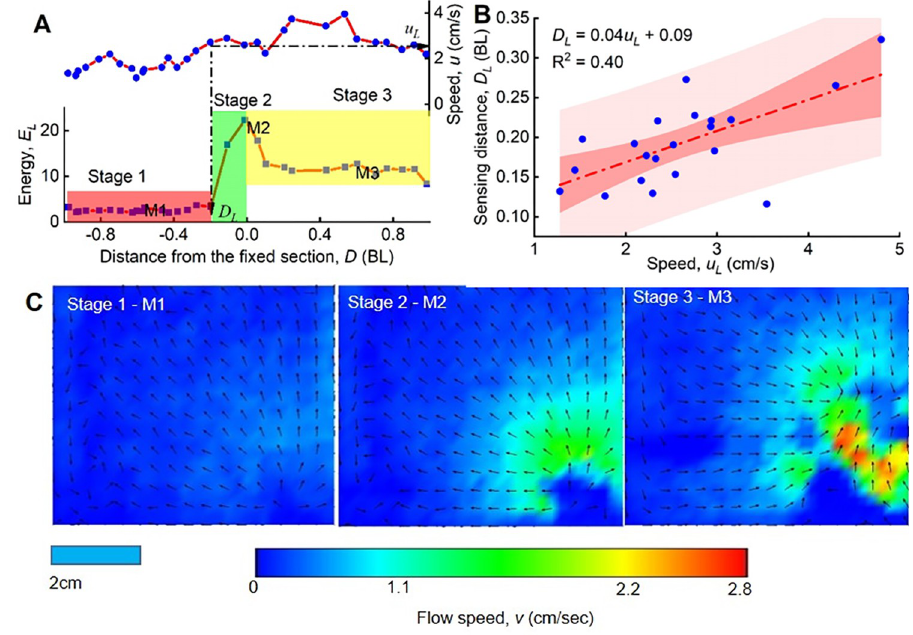
Fig 8. Sensing distance estimation. (A) Kinetic energy of flow ( E L ) at the laser plane and fish swimming speed ( u L ) in the three stages (approaching, entering, exiting laser plane) for a series of Experiment 2. The sensing distance D is the distance between the fish and the laser plane; (B) Maximum sensing distance ( D L ) versus fish swimming speed ( u L ) , D ) pairs; (C) showing representative water flow fields for a moment (M1, M2 and M3) showing concurrent ( u L L within each of the stages.